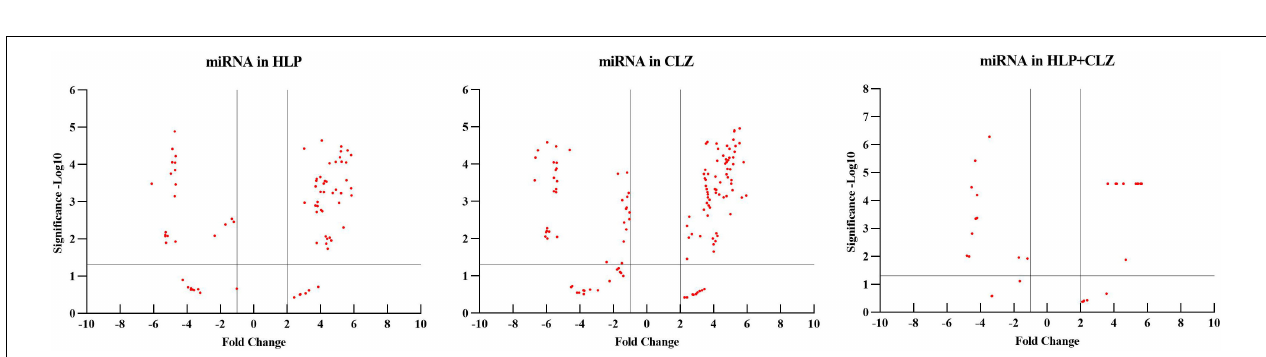
FIGURE 2 | Volcano plot of differentially expressed miRNAs beyond the threshold in the different treatment groups (HLP – haloperidol, CLZ – clozapine, and HLP + CLZ) and control (C).